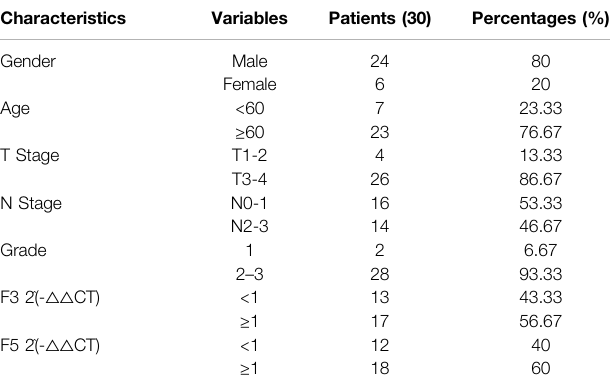
TABLE 1 | Characteristics of GC patients used for qRT-PCR.